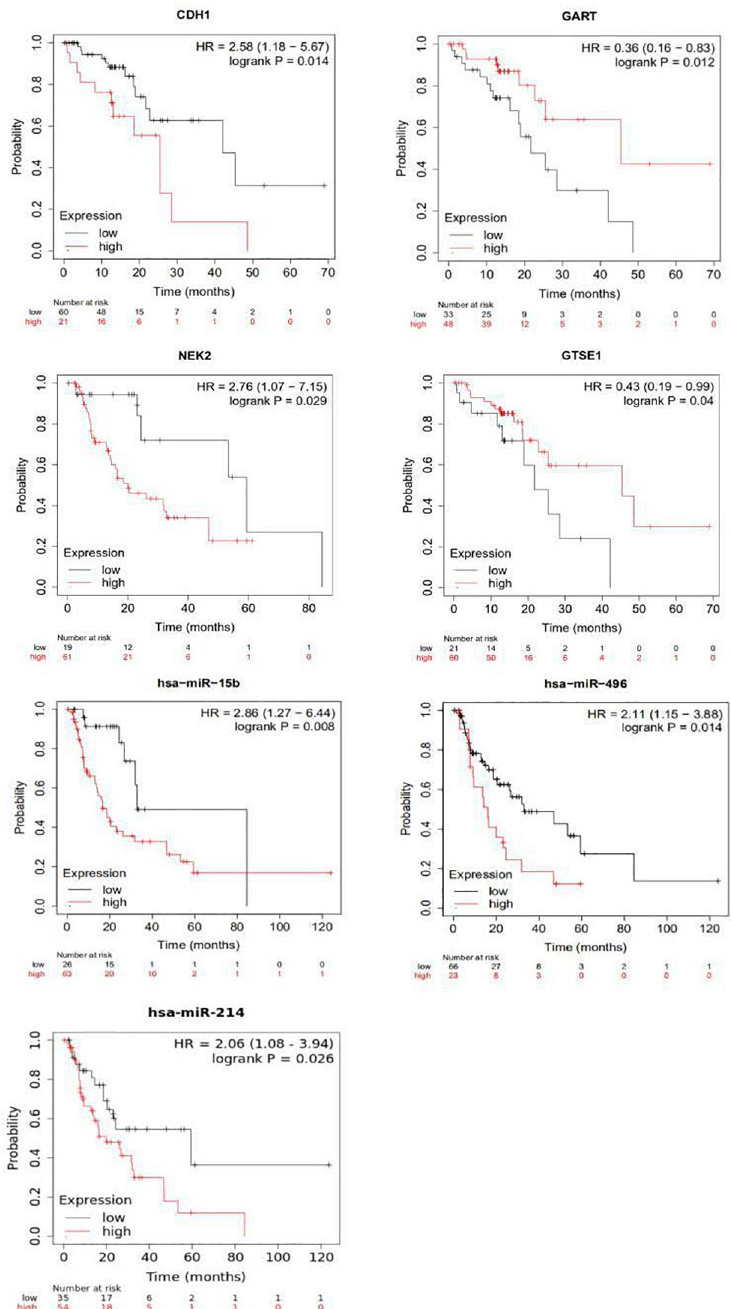
Fig 9. Prognostic values of DEMs and DEGs for overall survival in EAC patients. EAC patients were divided into low and high expression groups. Red polylines and text represent high expression groups, and gray polylines and text represent low expression groups. N represents the number of patients in each group. The horizontal axis represents the survival time in months, and the vertical axis represents the survival rate of patients in the corresponding time. Number at risk represents the number of patients who survived at the corresponding time